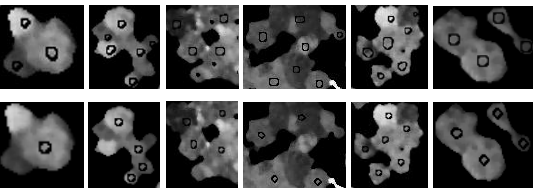
Fig. 11 Boundaries of identified tree tops superimposed on Band 1 (Top Row - With spectral constraints, Bottom Row - Without spectral